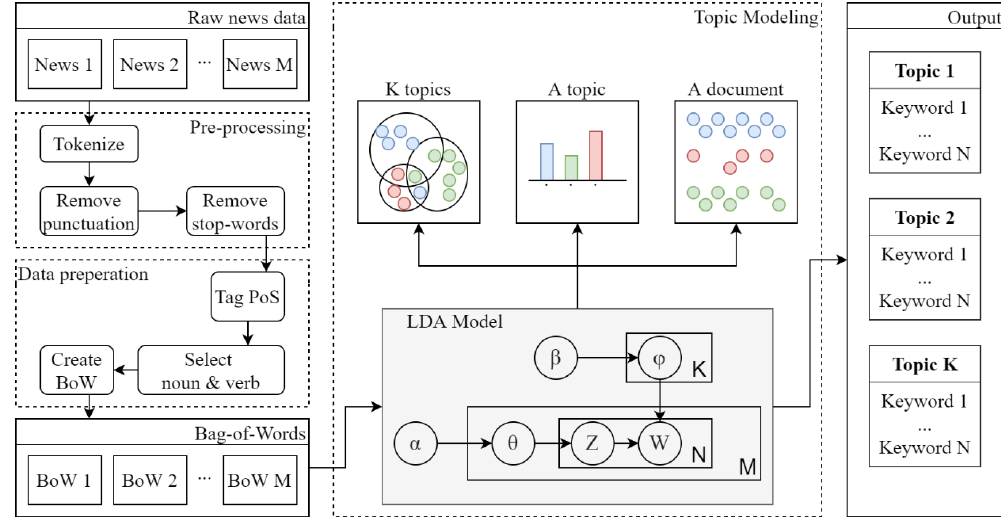
Figure 3. Implementation of the latent Dirichlet allocation (LDA) for retail price prediction of pork.